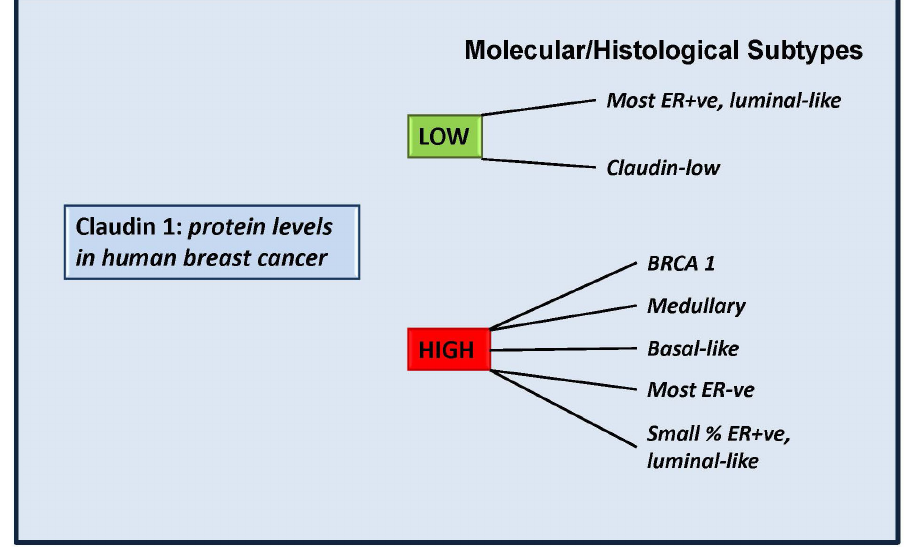
Figure 2. Claudin 1 levels in molecular/histological subtypes of breast cancer. Some molecular subtypes of human invasive breast cancer have been shown to exhibit low levels of claudin 1, in line with studies which suggest claudin 1 plays a tumor suppressor role in those tumors. However some aggressive forms exhibit high endogenous levels of claudin 1 and it is still to be determined whether in these tumors, claudin 1 is playing a tumor-facilitating role. BRCA1: a hereditary breast cancer. Patients carry a mutation of the breast cancer 1 (BRCA1) gene. Medullary: a subset of basal-like carcinomas that exhibit a high rate of p53 mutations [108].